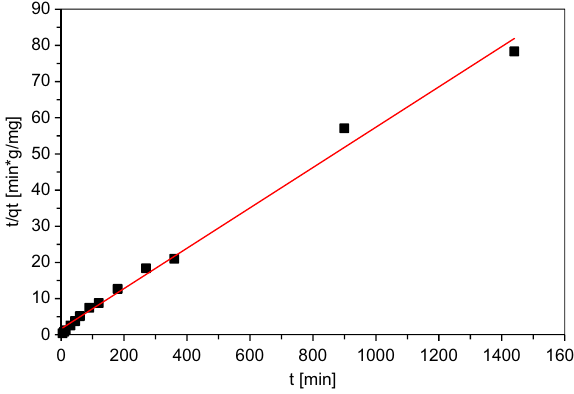
Figure 1. Pseudo-second order kinetic model for Eclipta alba powder.